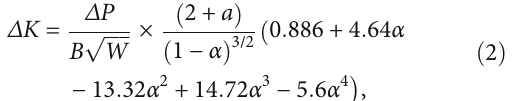
Figure 4: Designing parameters of smooth rectangular section specimen.